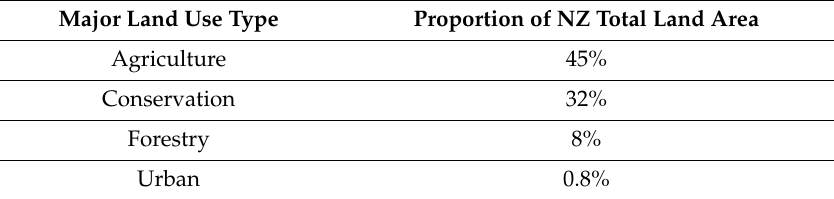
Table 1. The proportion of the New Zealand (NZ) total land area occupied by major land use types (This work is based on / includes Stats NZ’s data which are licensed by Stats NZ for reuse under the Creative Commons Attribution 4.0 International licence